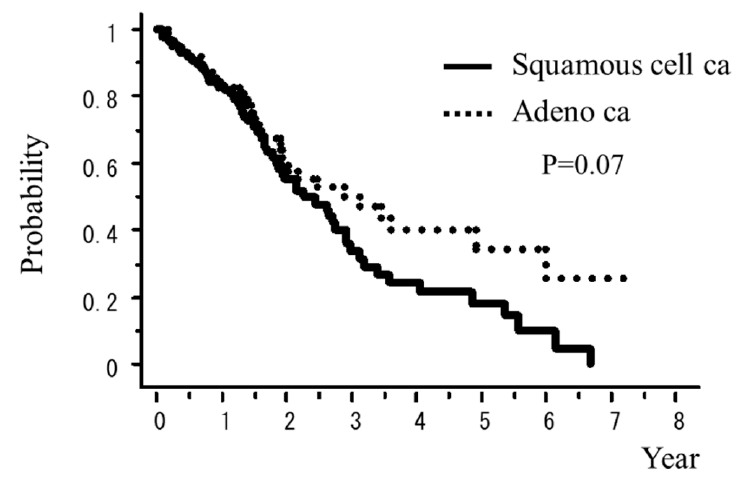
Figure 5. OS rate according to pathology (adeno ca vs squamous cell ca.).